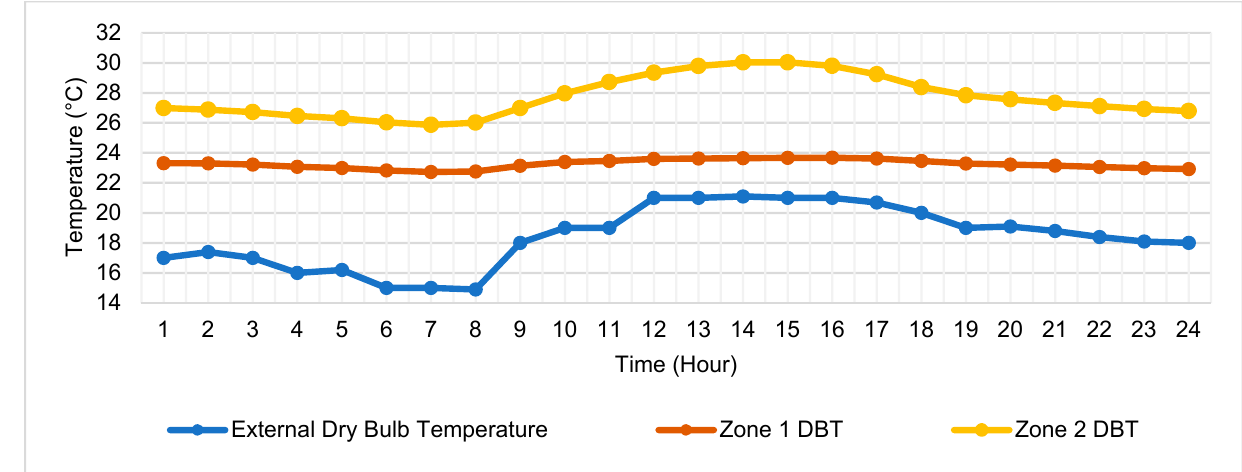
Figure 10. External dry bulb temperature and internal dry bulb temperatures in Hudhayfah Mosque by the hour during day 20 (Winter).